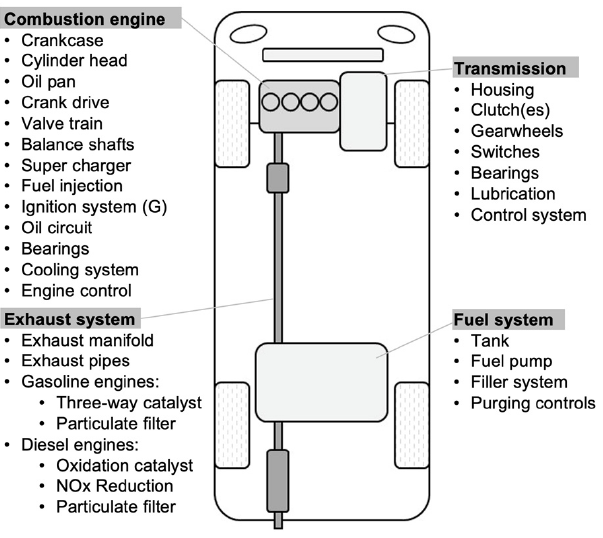
Figure 9. Powertrain structure of conventionally driven cars.